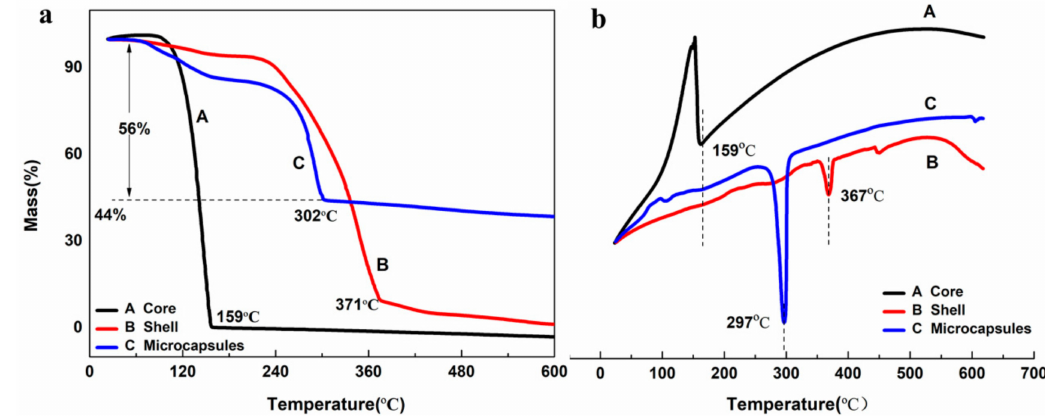
Figure 6. ( a ) TG and ( b ) DSC curves of the core, shell and